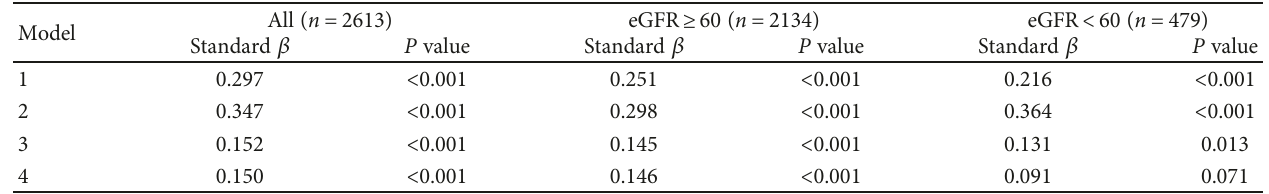
Table 3: Multivariate regression analyses with ACR as a dependent variable and baPWV as an independent variable. Model